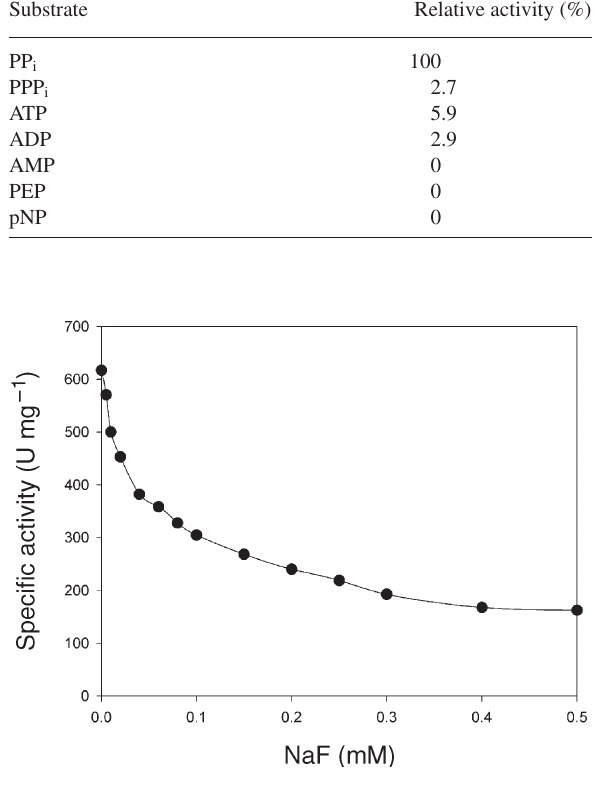
Figure 4. Inhibition of Ph PPase activity by NaF. The specific activity was determined at the indicated NaF concentrations, as described in Materials and